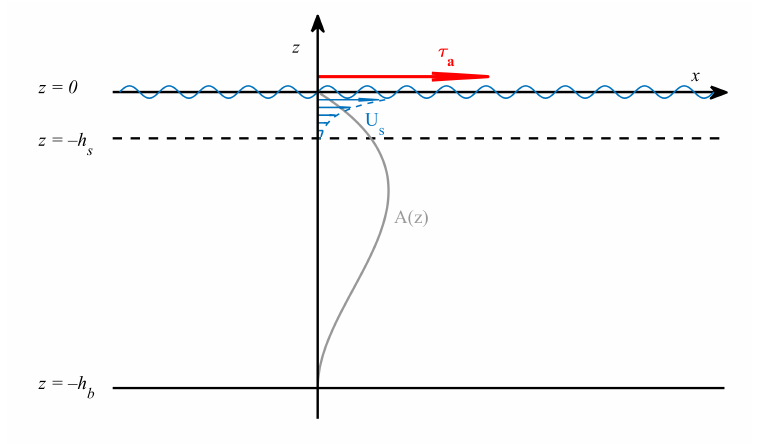
Figure 1. Schematic diagram of the wave-modified Ekman coordinate system. The red vector denotes wind stress τ a , the blue sinusoidal curve represents the propagation of waves, the blue vectors are the Stokes drift at selected depth, h s is the Stokes depth scale, and h b is the boundary layer depth. An example of the eddy viscosity A ( z ) in KPP is shown by the grey